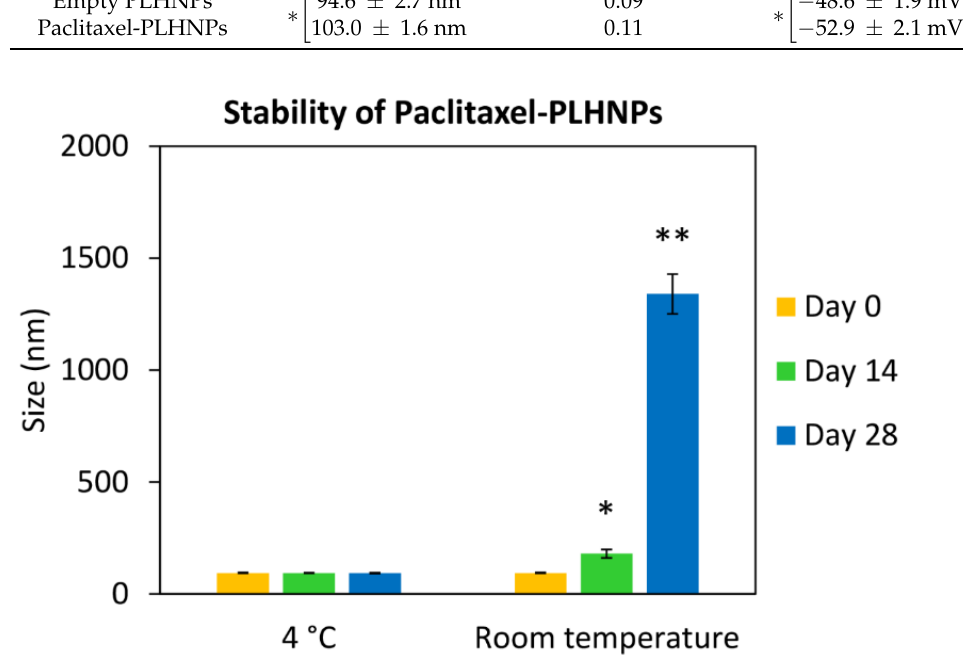
Figure 2. Storage stability of paclitaxel-PLHNPs. Data are reported as mean ± SD from three inde- pendent experiments, * and ** p < 0.05 compared to Day 0.